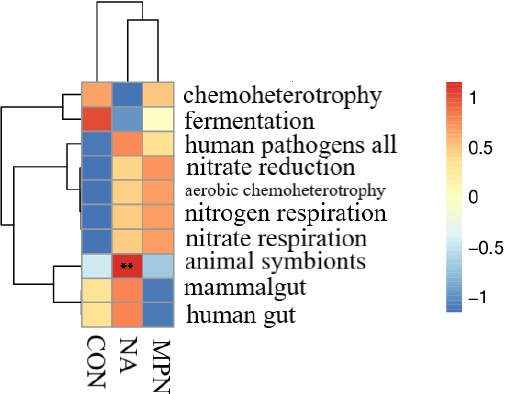
Figure 8. Prediction of microbial function of colonic microbiota in weaned piglets by PICRUST. Heatmap of the predicted microbial function in the three treatment groups. CON, control group; NA, niacin group; MPN, GPR109A antagonist group. ** p < 0.01.